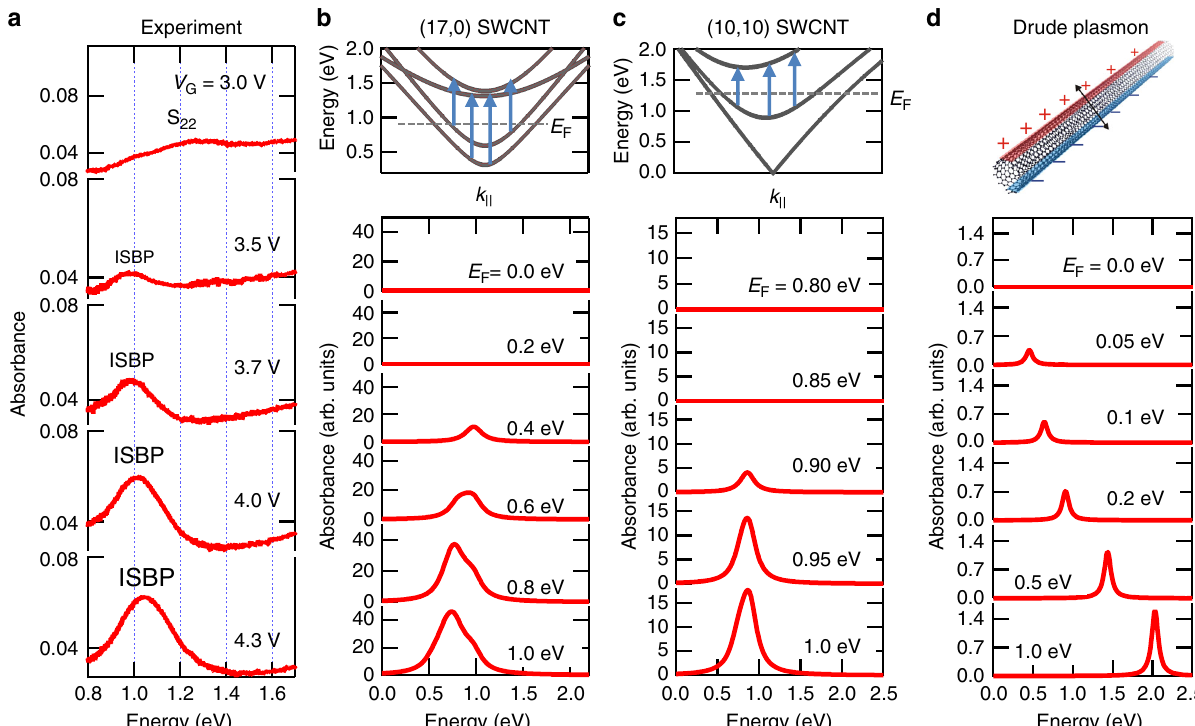
Fig. 4 Experimental spectra and theoretical simulations for the electron density dependence of the intersubband plasmon peak. a Optical absorption spectra showing how the ISBP peak evolves as the gate voltage increases. b Calculated single-particle absorption spectra for a (17, 0) semiconducting nanotube at different Fermi energy values. c Calculated single-particle absorption spectra for a metallic (10, 10) nanotube at different Fermi energy values. d Calculated perpendicular-polarization absorption spectra for a SWCNT with a diameter of 1.4 nm at different Fermi energy values based on a